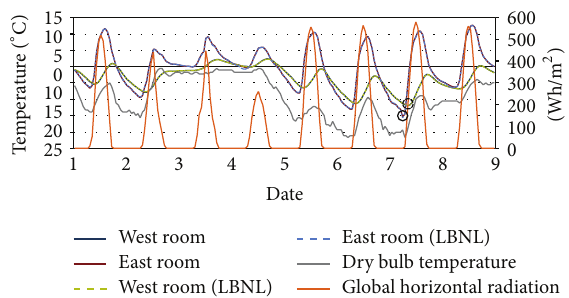
Figure 12: Temperature comparison of Test Case 2 for February 1st to 9th. Solid (6AM, February 7th) and broken (8AM, February 7th) circles point out the lowest temperature in the East and West Rooms, respectively, for the two models. The temperature curves overlap between the two